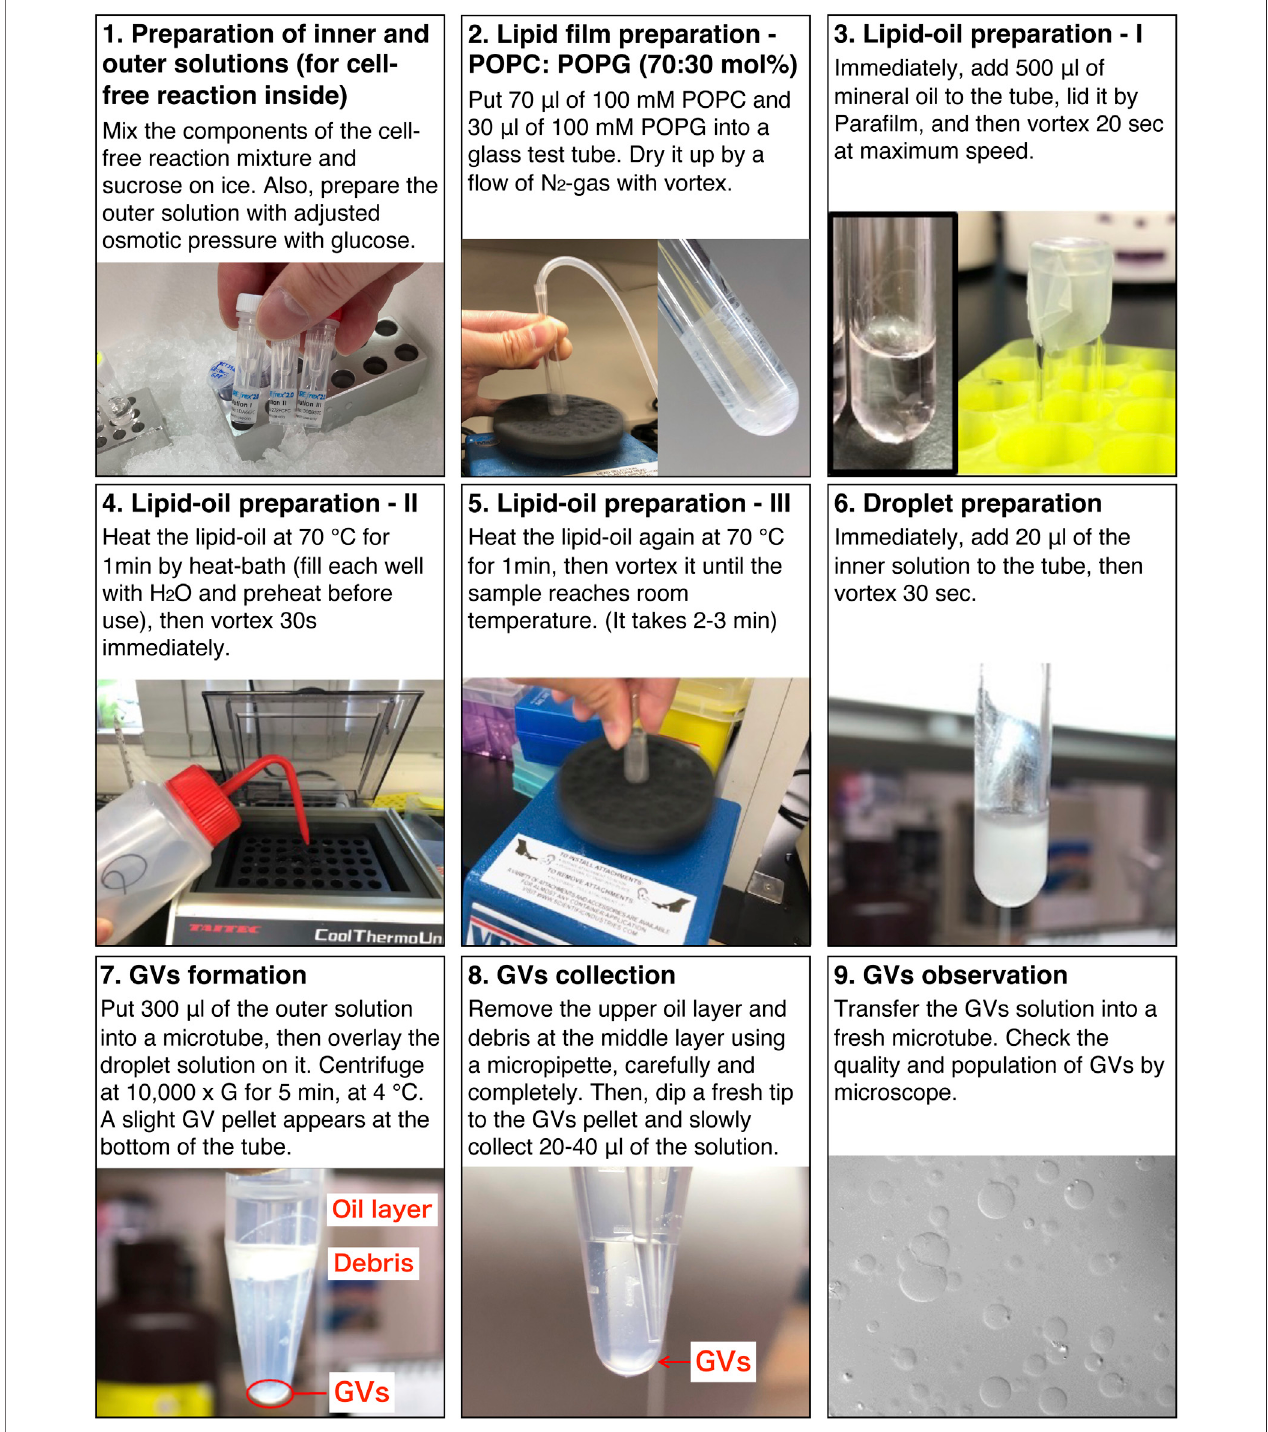
FIGURE 2 | Stepwise protocol for the preparation of arti fi cial cells. The details of the inner and outer solutions are provided in Tables 2 , 3 , respectively.